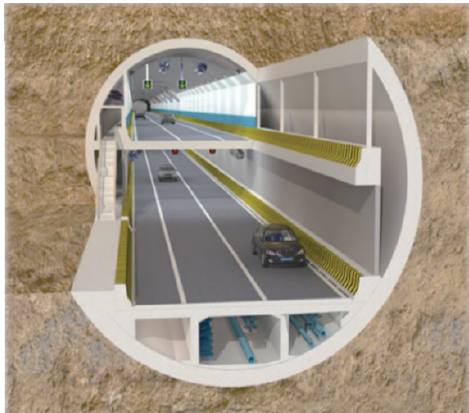
Figure 2. Cross-section of the shield tunnel.